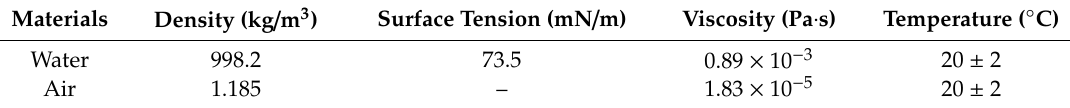
Figure 5. Experimental set-up and particle size measurement. Table 1. The properties of the water and gas.